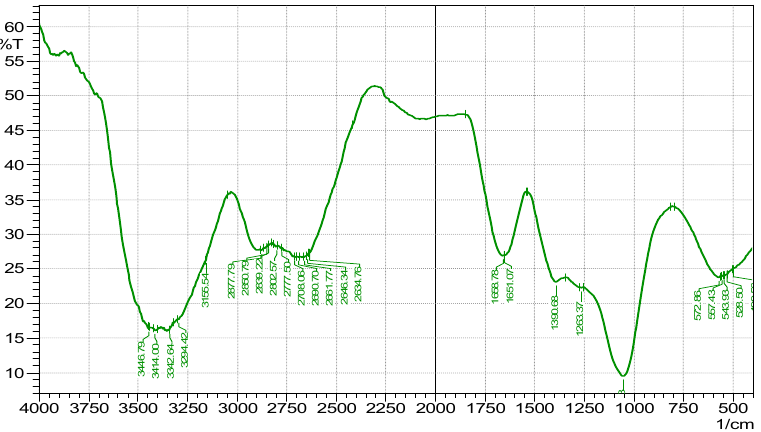
Fig. 4. FTIR spectrum of IC dye with corn leaves after adsorption.